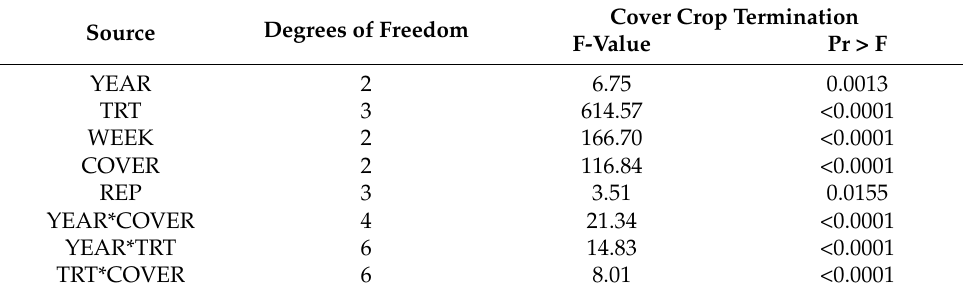
Table 4. Analysis of variance results for cover crop termination.